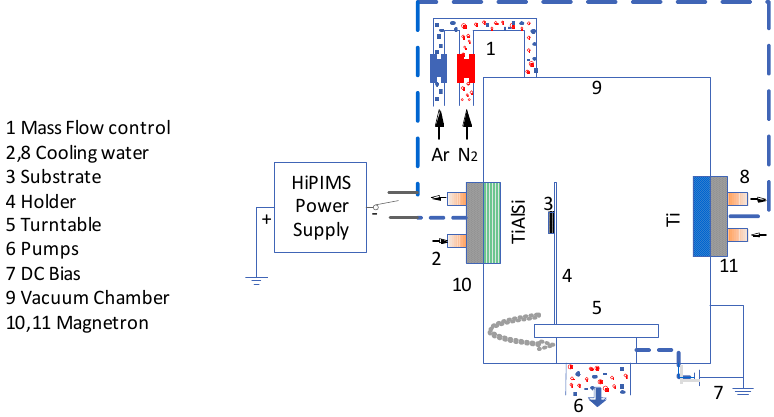
Figure 1. Deposition apparatus for TiAlSiN/Ti multiayer coatings.